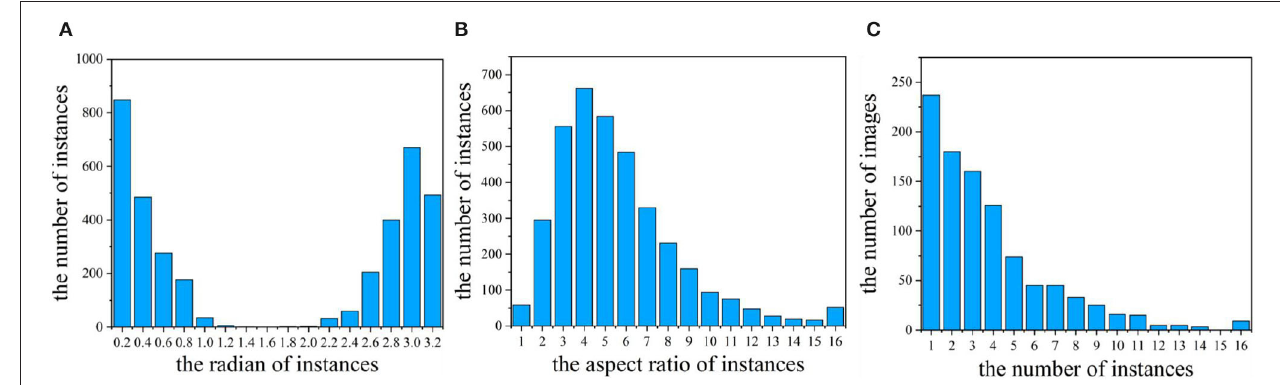
FIGURE 5 | Characteristics of dataset. (A) Orientation histogram for all instances; (B) aspect ratio histogram for all instances; and (C) number of instances for all